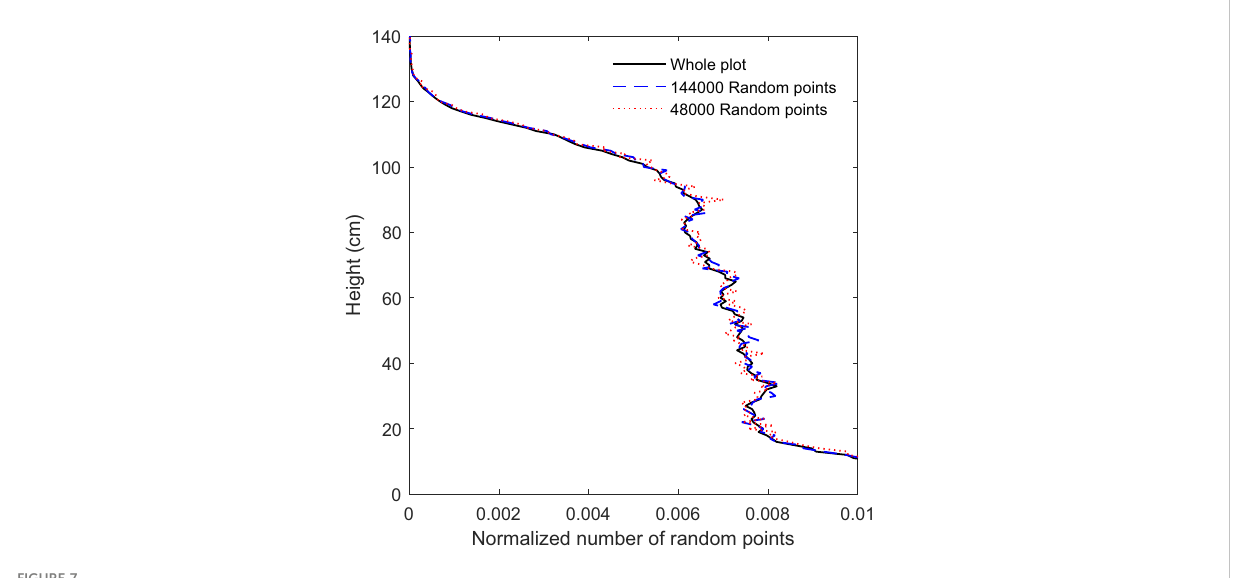
FIGURE 7 The CVP obtained from LiDAR data provided with 48000, 144000 and whole plot